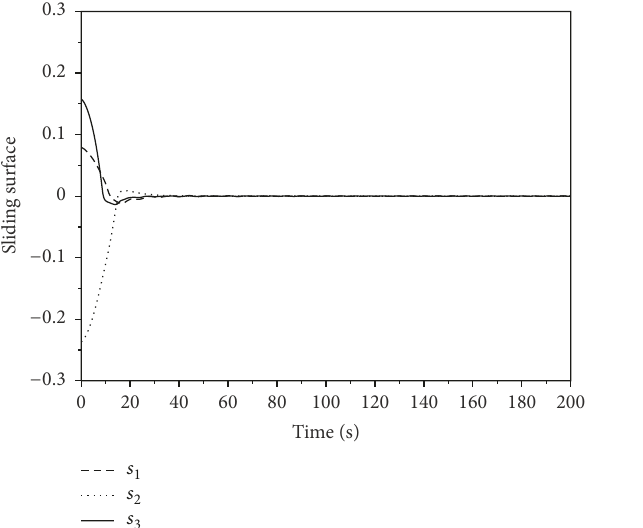
Figure 13: First and second modes under controller (50).